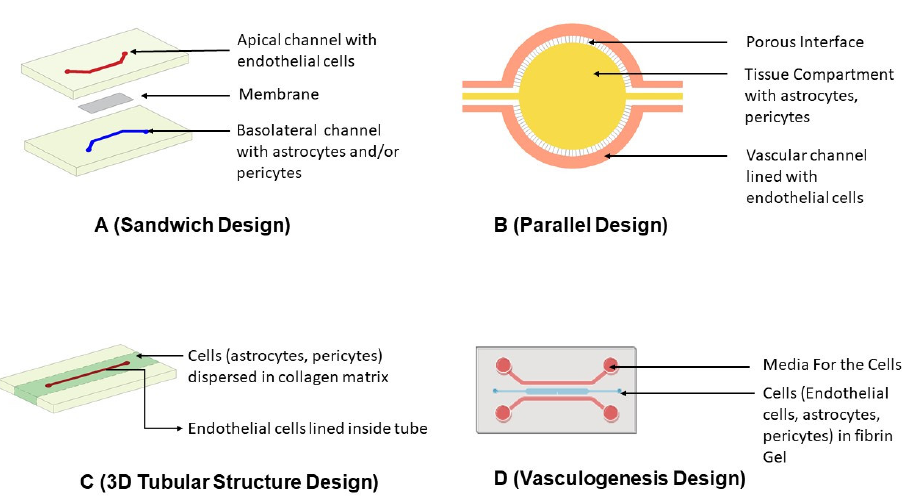
Figure 5. Schematic diagram of the design strategies adopted in the fabrication of microfluidic chip- derived in vitro BBB models ( A ) Sandwich Design: Upper and lower PDMS channel separated by a membrane. The apical channel is plated with endothelial cells, whereas the basolateral channel consists of astrocytes and/or pericytes. ( B ) Parallel Design: This consists of two parallel horizontal channels with perforations in the inner channel that provide contact between them. The outer channel has endothelial cells, whereas inner channel consists of astrocytes or pericytes dispersed in matrix. ( C ) 3D Tubular Structure Design: This consists of central cylindrical channel in collagen matrix. The central cylindrical channel has endothelial cells, whereas the matrix has astrocytes or pericytes dispersed in matrix. ( D ) Vasculogenesis Design: This consists of the central channel having endothelial cells, astrocytes, or pericytes dispersed in matrix flanked by two channels nourishing the media.